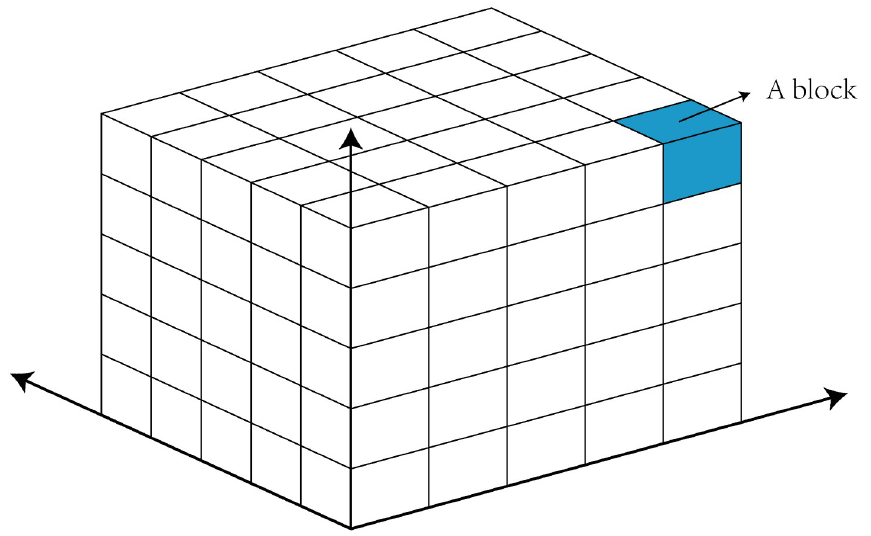
Fig 1. Schematic diagram of the 3D grid-based velocity model. Each block has a velocity value.